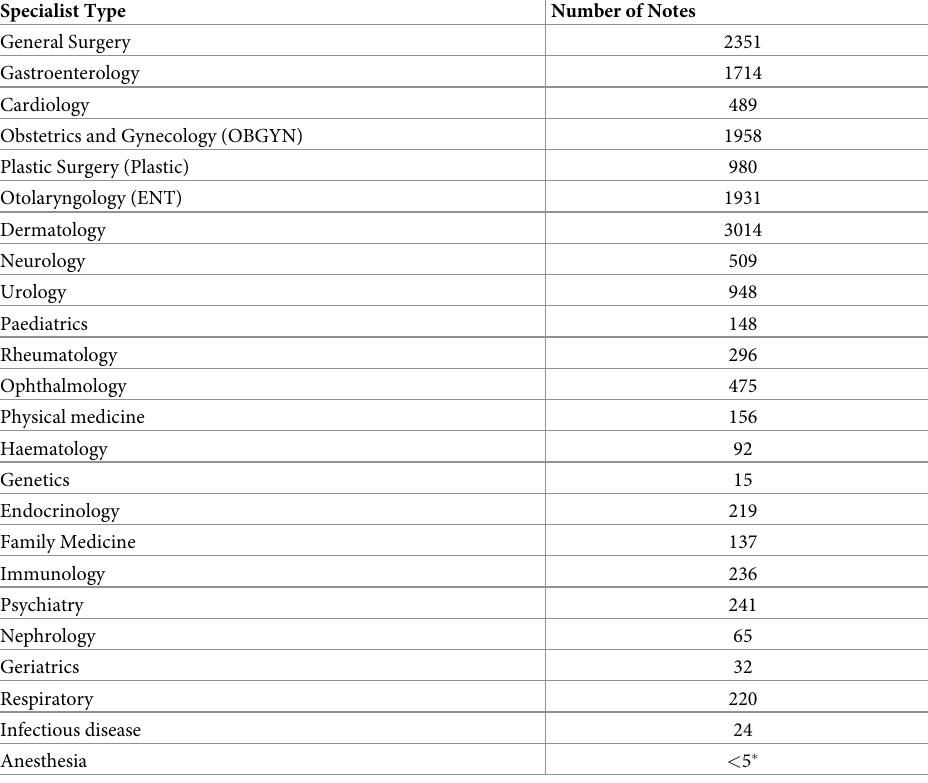
Table 1. The number of notes per specialist type. Notes with fewer than 6 tokens were not counted as they were not informative, per manual checking. The specialty “internal” was also removed as the types of medical consultation done by an internal specialist overlaps with many individual specific specialties such as cardiology, gastroenterology, among others. If present, the names within parentheses represent how the specialty is represented in later